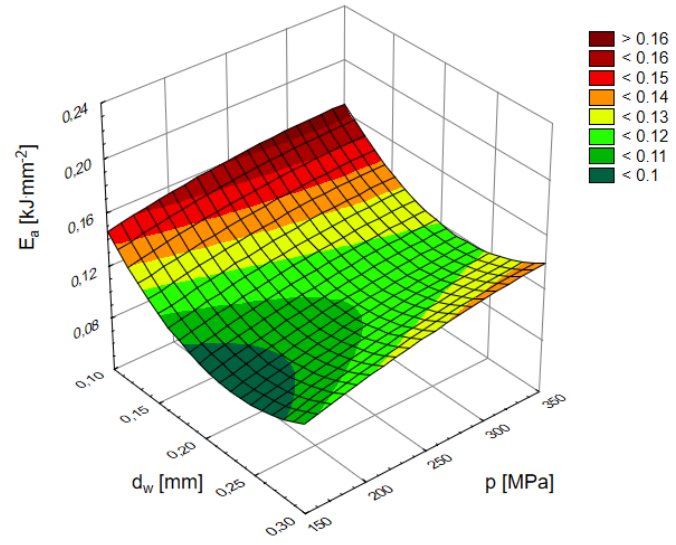
Figure 14. Influence of pressure and waterjet diameter on the energy consumption of granite with abrasive waterjet: feed speed v p = 3 mm·s − 1 , flow of abrasive 𝑚(cid:4662) (cid:3028) = 6.7 g·s − 1 . abrasive waterjet: feed speed v p = 3 mm · s − 1 , flow of abrasive